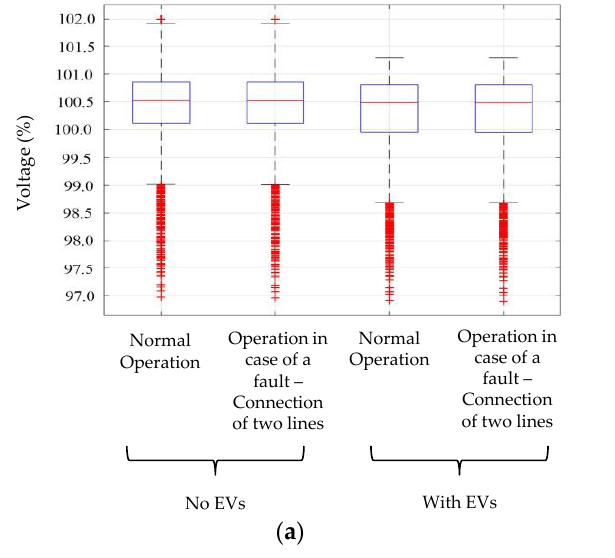
Figure 8. ( a ) Boxplot for the minimum voltage values in Astypalea when considering the presence of EVs, ( b ) Explanation of the boxplot